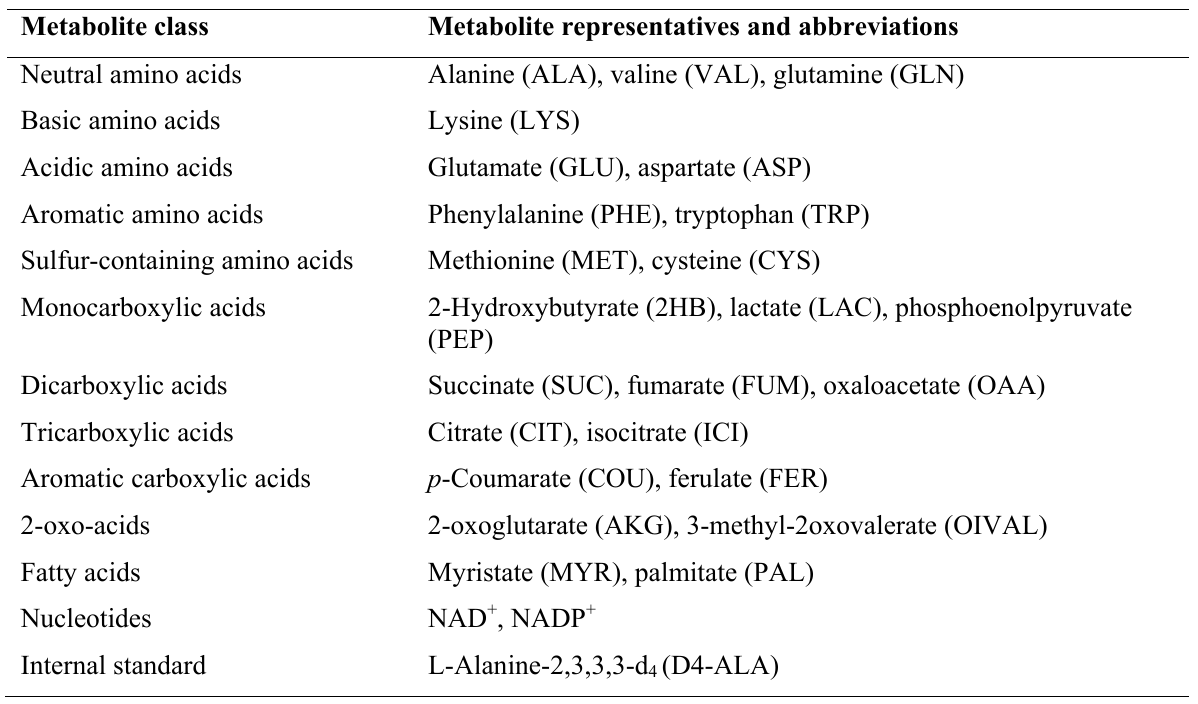
Table 1. List of metabolite standards used to assess the analytical performance of chemical